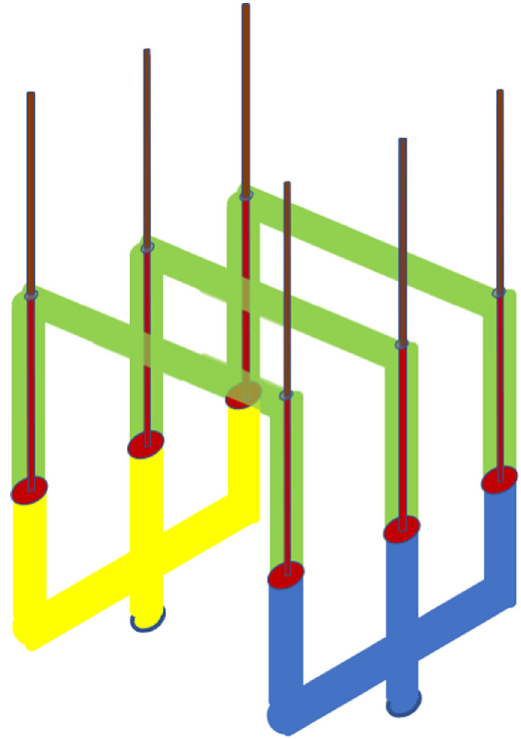
Fig. 3 An implementation for ‘ interlocked adjuster ’ . Each cylinder fi lled with green liquid is connecting blue and yellow cylinders. Due to the interlocking adjuster, if a blue liquid level E i increases (decreases), the corresponding yellow liquid level C i decreases